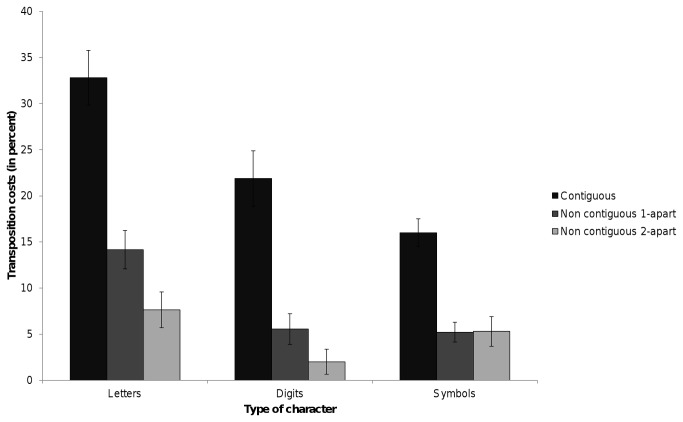
Transposition costs (related – unrelated) in percentage obtained in each experimental condition in the experiment.